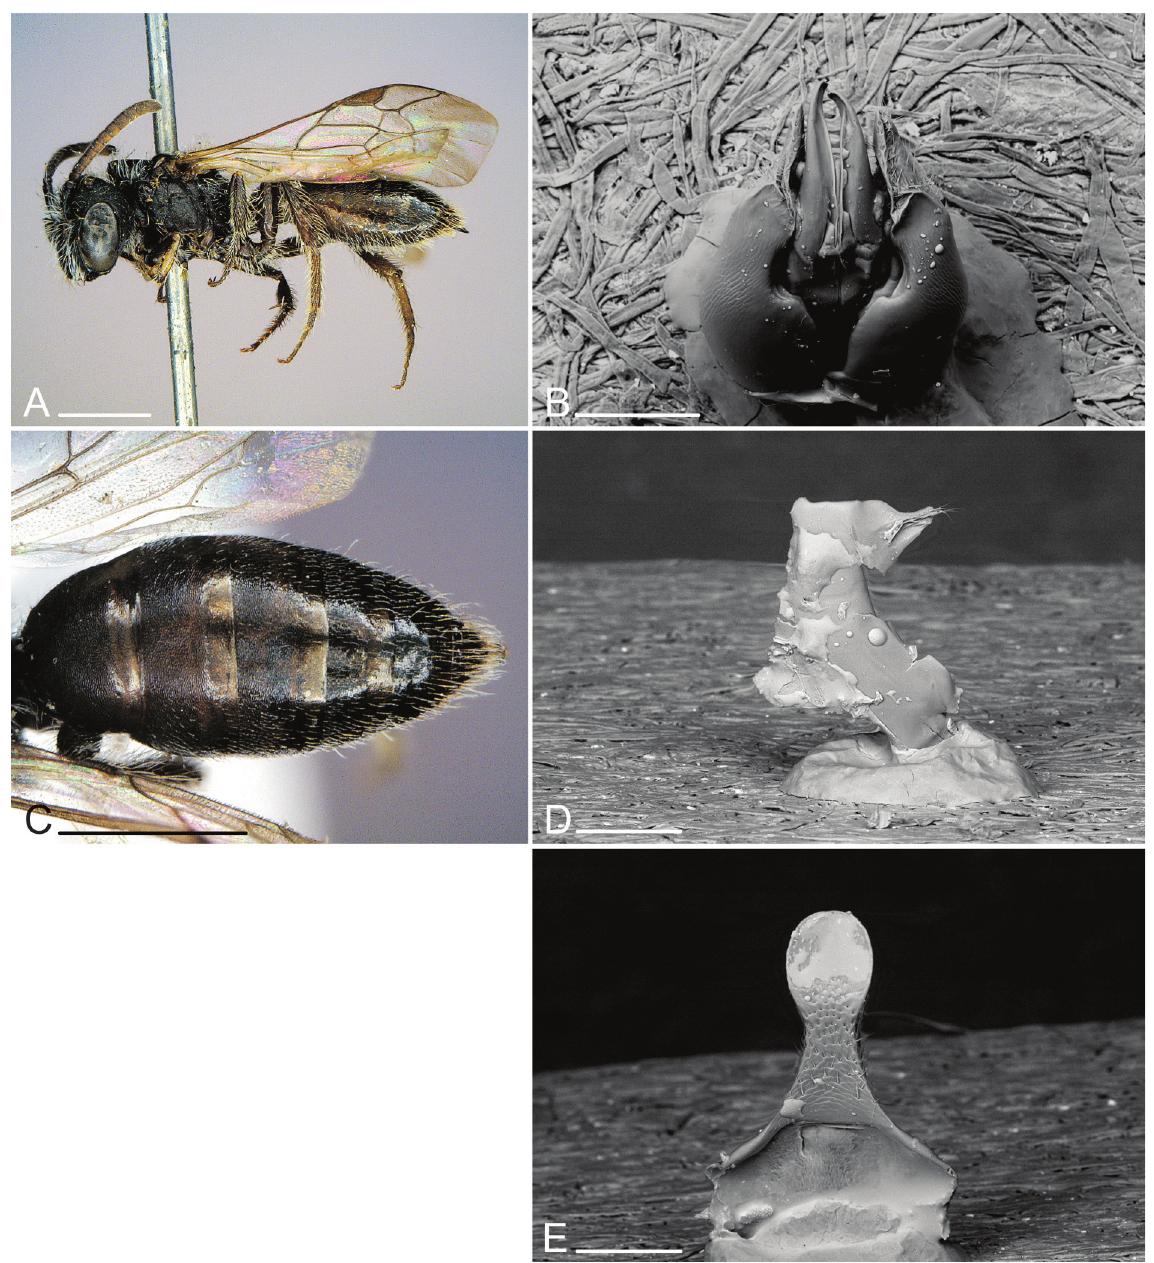
Fig. 20. Scrapter nigritarsis sp. nov., ♂. A . Lateral view. B . Genitalia (dorsal view, SEM). C . Metasoma (dorsal view). D . S7 (dorsal view, SEM). E . S8, apical end (SEM). Scale bars: photos: 1 mm, SEM: 0.1